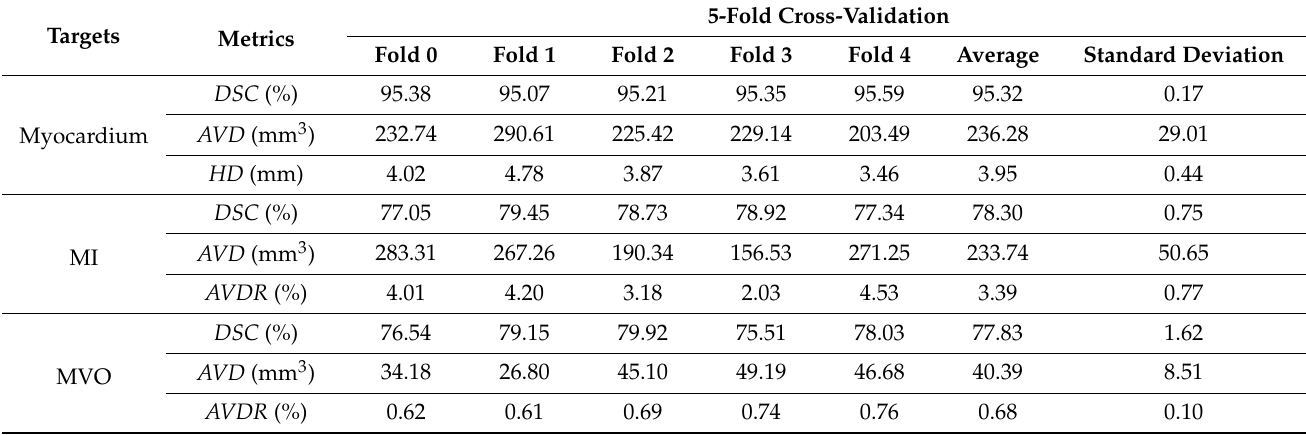
Table 2. Internal quantitative assessment on 5-fold cross-validation